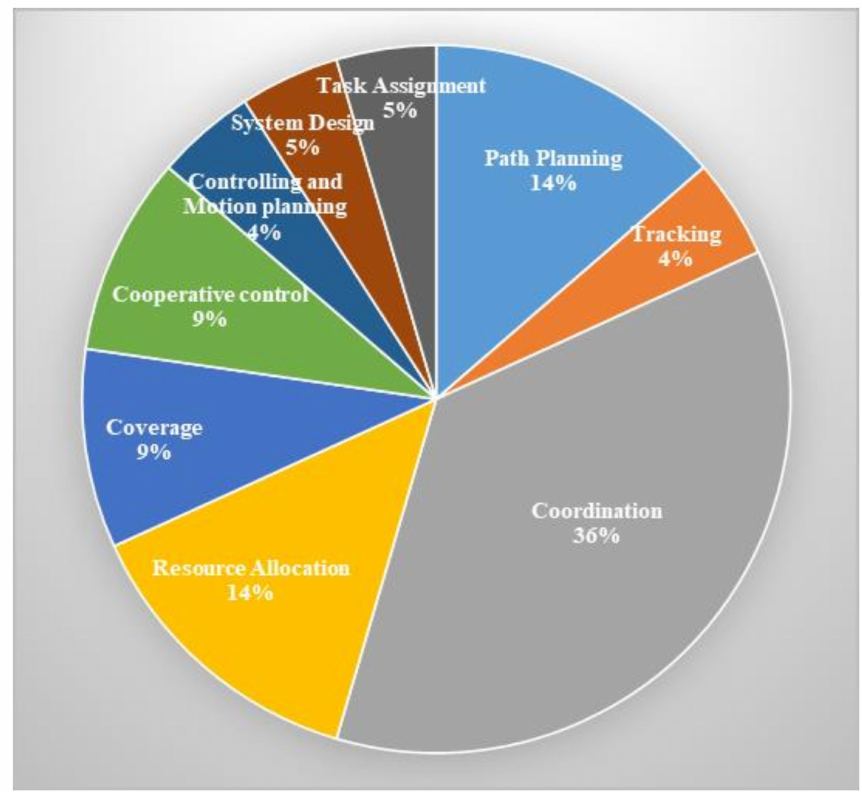
Figure 11. The main research topics that used multi-drones were covered in the papers